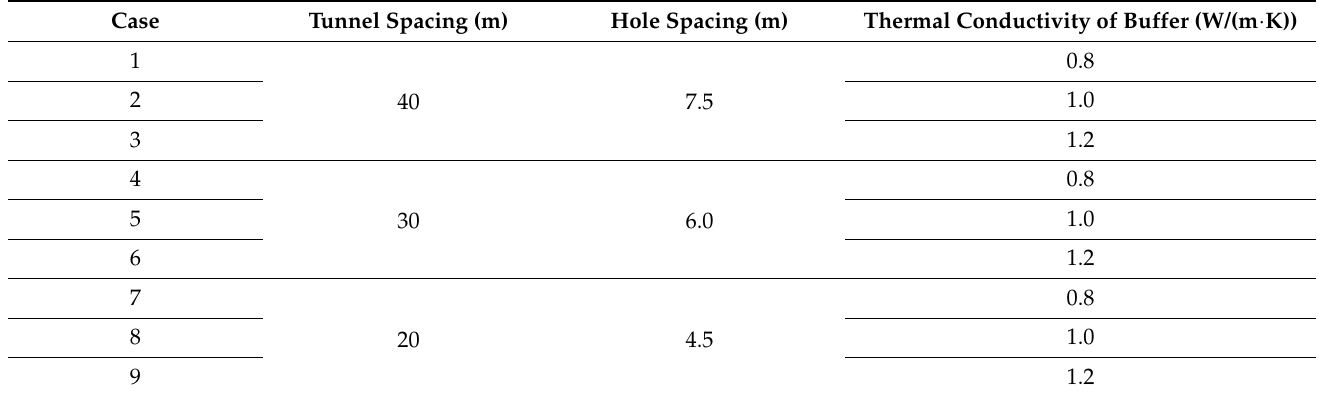
Table 3. Case set up for parametric study.